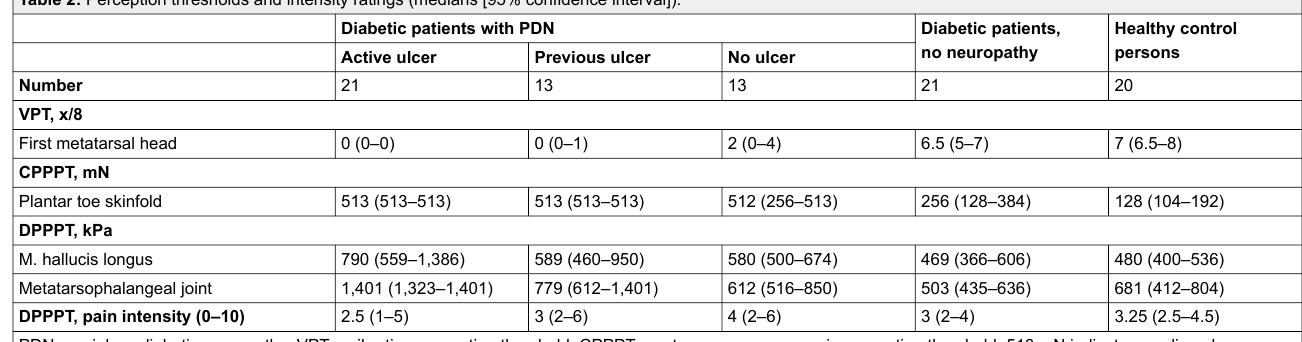
Table 2: Perception thresholds and intensity ratings (medians [95% confidence interval]).